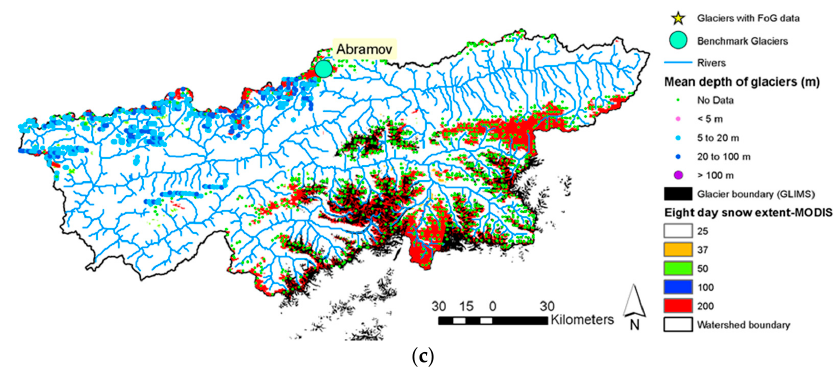
Figure A2. Glacier snow depth and area across the ( a ) Mendoza, ( b ) central Chile, and ( c ) Vakhsh river basins. Minimum snow cover area from MOD10A2 at the end of the melting season from February 2002 to 2010 was considered as glacier or permanent snow cover for Mendoza, central Chile, and part of the Vakhsh basin. Green dots show locations of glaciers with no depth information.